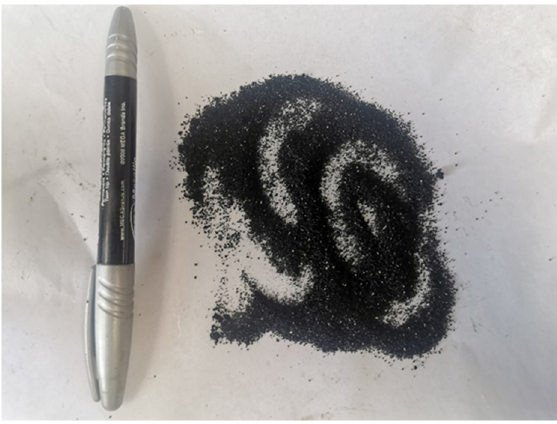
Figure 2. The crumb rubber used in this study. Table 1. Crumb rubber’ basic properties used in this study.